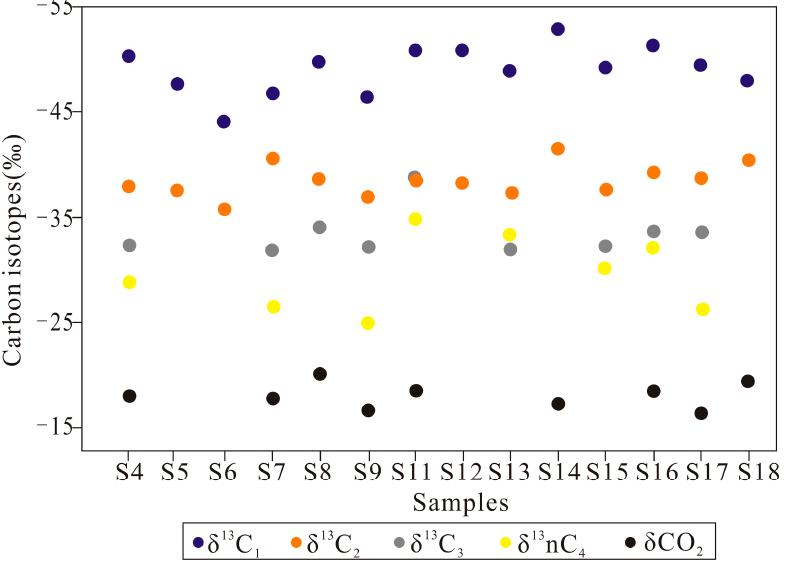
Figure 4. The carbon isotopes of different gas components. δ 13 C 1 : methane carbon isotopes; δ 13 C 2 : ethane carbon isotopes; δ 13 C 3 : propane carbon isotopes; δ 13 nC 4 : n-butane carbon isotopes; δ CO 2 : carbon dioxide carbon isotopes.